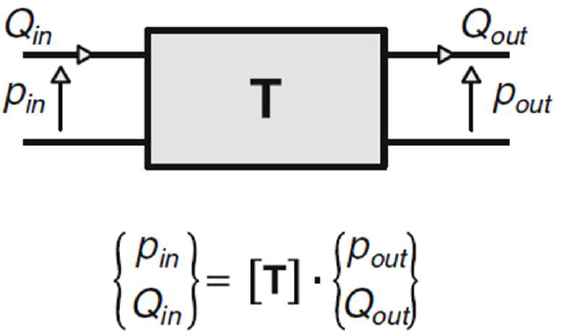
Figure 1. Equivalent acoustic model of a single element—transfer matrix representation.